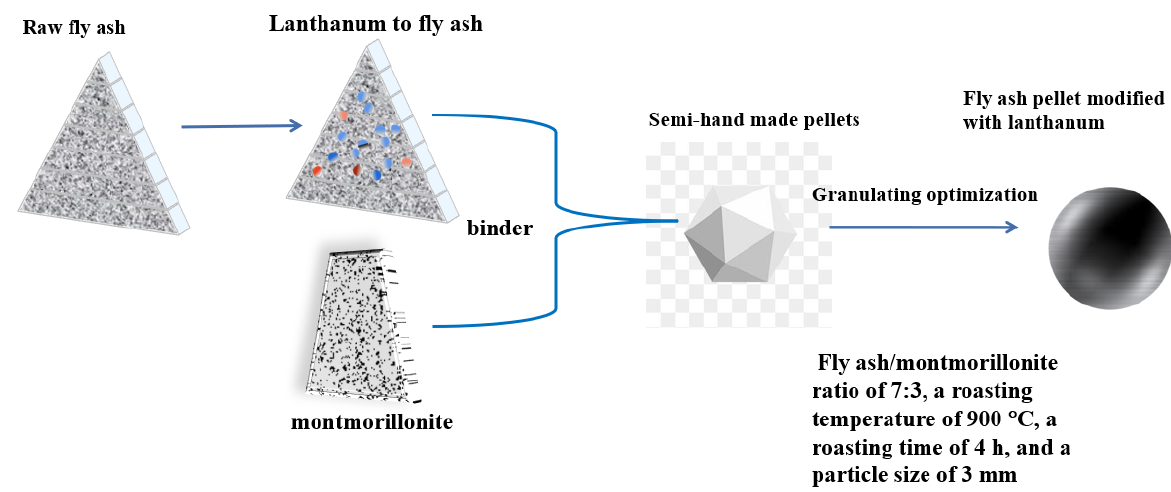
Figure 1. Process flow diagram.